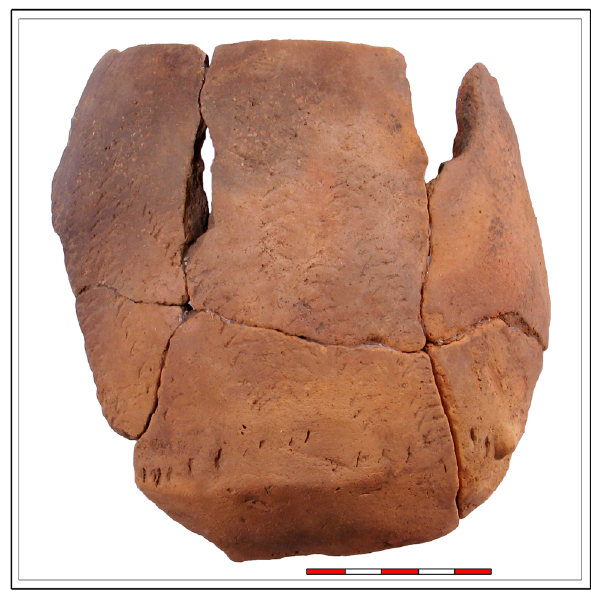
Figure 10: Pear - shaped vessel with tremolo ornamentation from Targowisko site 12 – 13 ( acc. to Czerniak et al., 2007 )